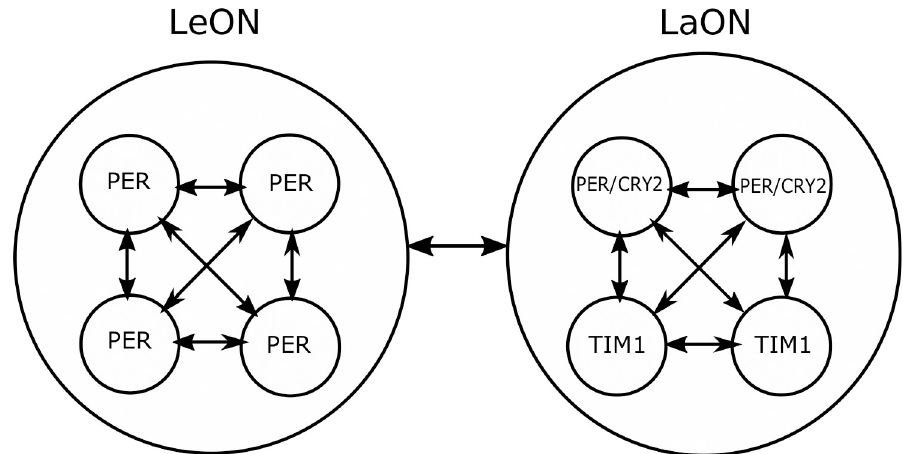
Fig 11. Two circadian oscillator networks with different molecular clockworks control locomotor activity rhythms of the Madeira cockroach. The lead oscillator network (LeON) with a shorter period and the lag oscillator network (LaON) with a longer period, each consist of four single oscillator neurons. In LeON only PERIOD (PER) constitutes the negative limb of the core transcriptional feedback loop in all of the circadian pacemaker neurons. However, in LaON two different cell types exist, one with PER and CRYPTOCHROME 2 (CRY2), and the other with TIMELESS1 (TIM1) as transcriptional